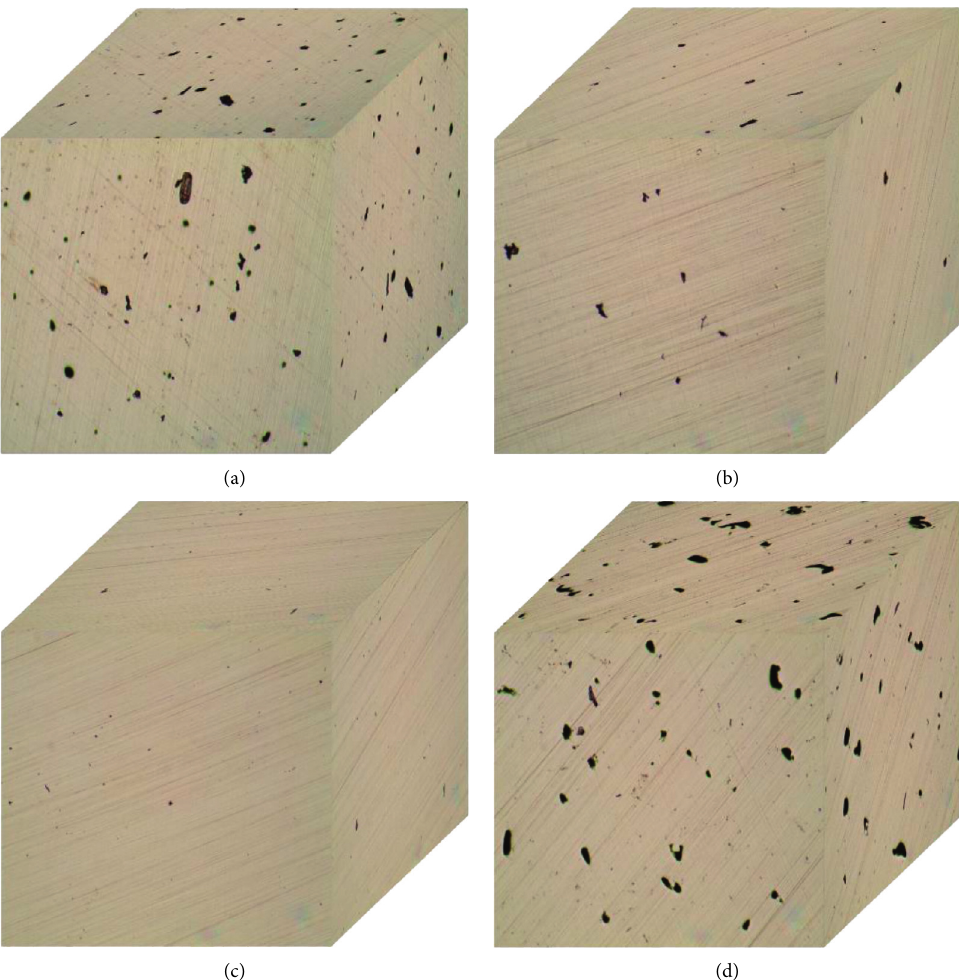
Figure 8: Internal defects of the specimen. (a) 350mm/s, (b) 650mm/s, (c) 950mm/s, (d) 1250mm/s.